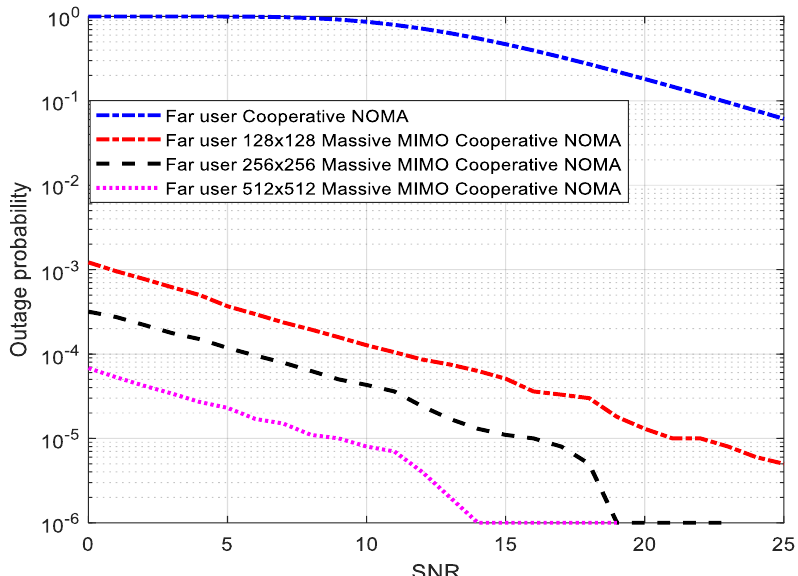
Figure 9. Outage probability against SNR for three different far users (cooperative NOMA, massive- MIMO – NOMA cooperative). MIMO–NOMA